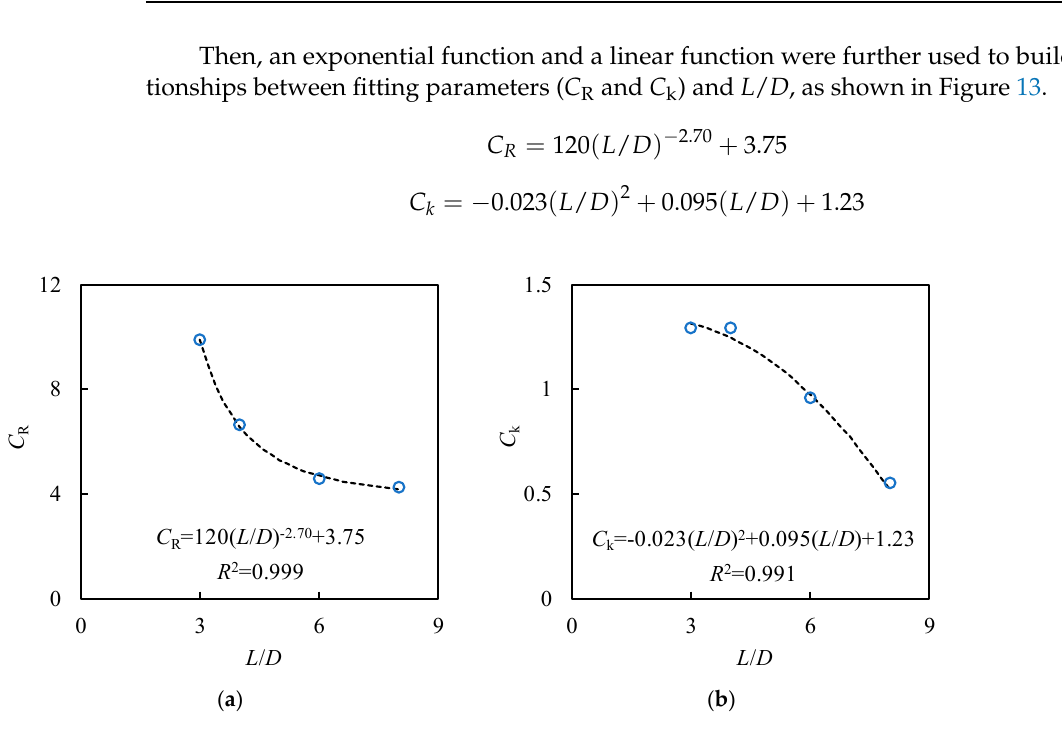
Figure 13. Relations between fitting parameters and L / D : ( a ) Relations between C R and L/D , ( b ) Relations between C k and L/D .